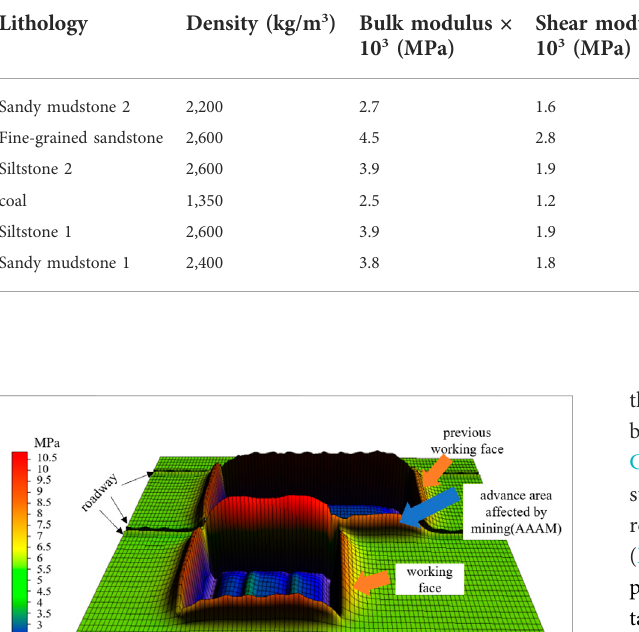
TABLE 1 Lithology and rock physical and mechanical parameters.